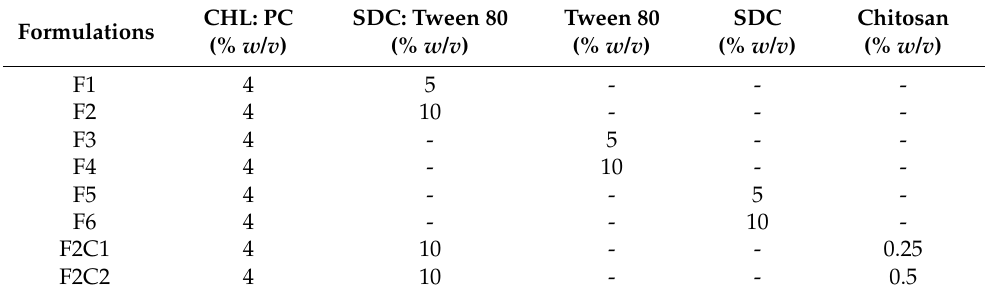
Table 1. Formulation design of apigenin- bilosomes and chitosan coated apigenin bilosomes.